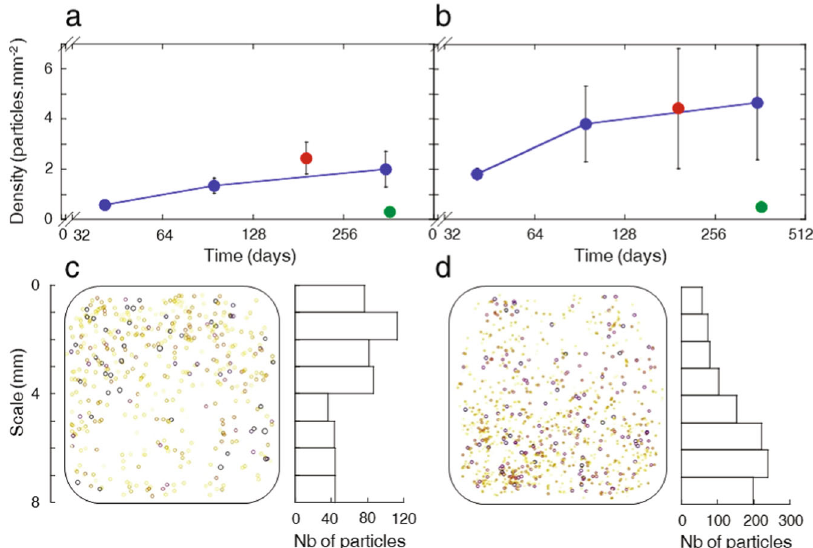
Fig. 3 Surface contamination kinetics on FDTS coating in MATISS-2 campaign. a Density values of the coarse particles (50 μ m 2 < Area < 1500 μ m 2 ) measured on surfaces of 8 x 8 mm. b Density values of the fi ne particles (0.50 μ m 2 < Area < 50 μ m 2 ). The blue curves show the kinetics of the surface contamination increase. Red and green symbols show the FDTS-surfaces exposed for 193 days in MATISS-1 campaign and 365 days in MATISS-2.5 campaign, respectively, in different experimental periods than that of the blue dots. The FDTS-surfaces exposed Matiss-2.5 campaign was deposited on a borosilicate glass lamella (green dot) and suprasil lamella (green triangle). Error bars represent the standard deviation of the data. c Schematic representation of the location of the coarse particles on FDTS surfaces within a window exposed for 354 days (left). The side near the closest aperture is in y position = 0. Each particle is represented by a circle whose color (yellow/orange/violet scale from 50 to 500 μm²) and sizes (ratio 1 to 1.5 from 50 to 1500 μm²) are proportional to the particle surface. The particles number histogram versus the y position (vertical axis) of particles on surfaces (right). d Same representation for fi ne particles with a yellow/orange/violet scale from 0 to 50 μm² and size ratio of 1 to 1.5 for 0 to 50 μm² particle